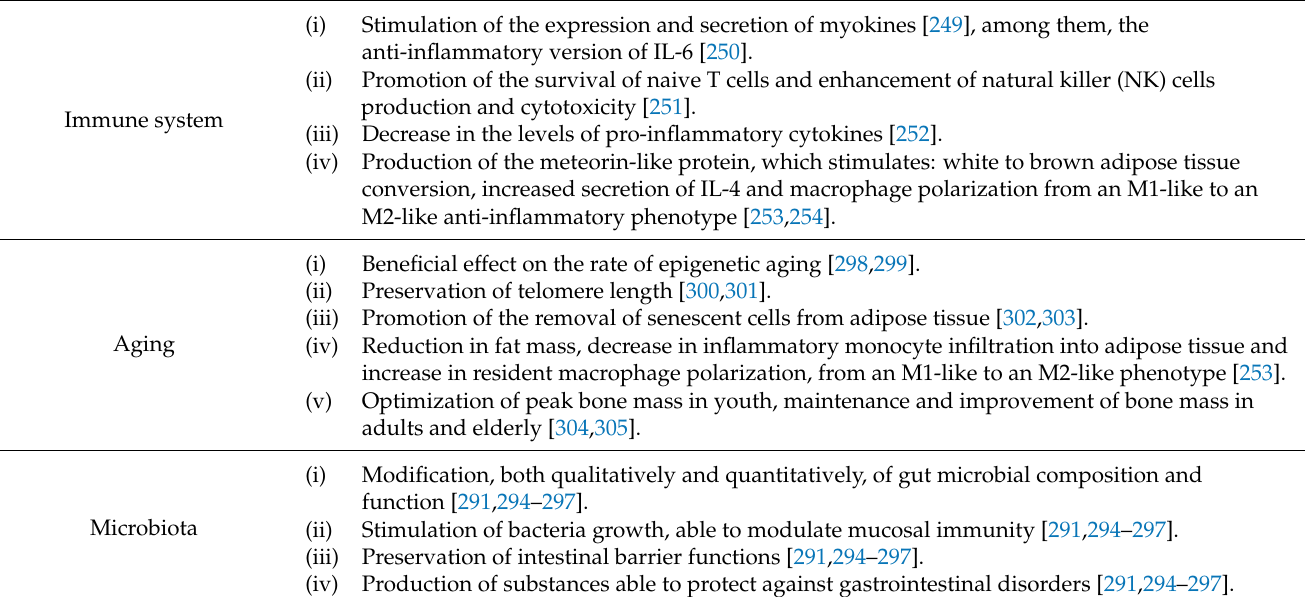
Table 6. Major physiological effects of physical activity and its outcomes on non-communicable diseases (NCDs) prevention and